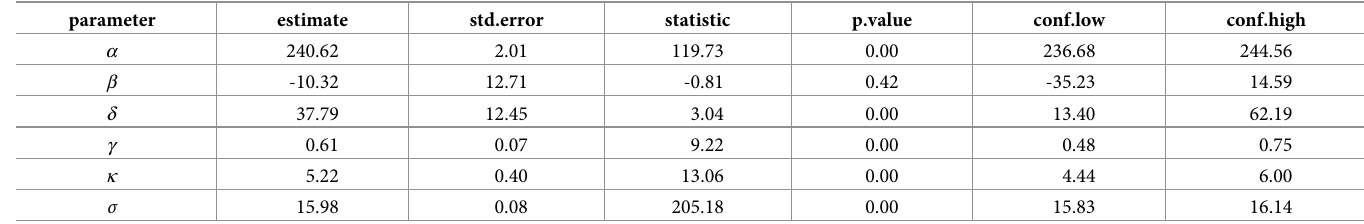
Table 3. Structural parameter